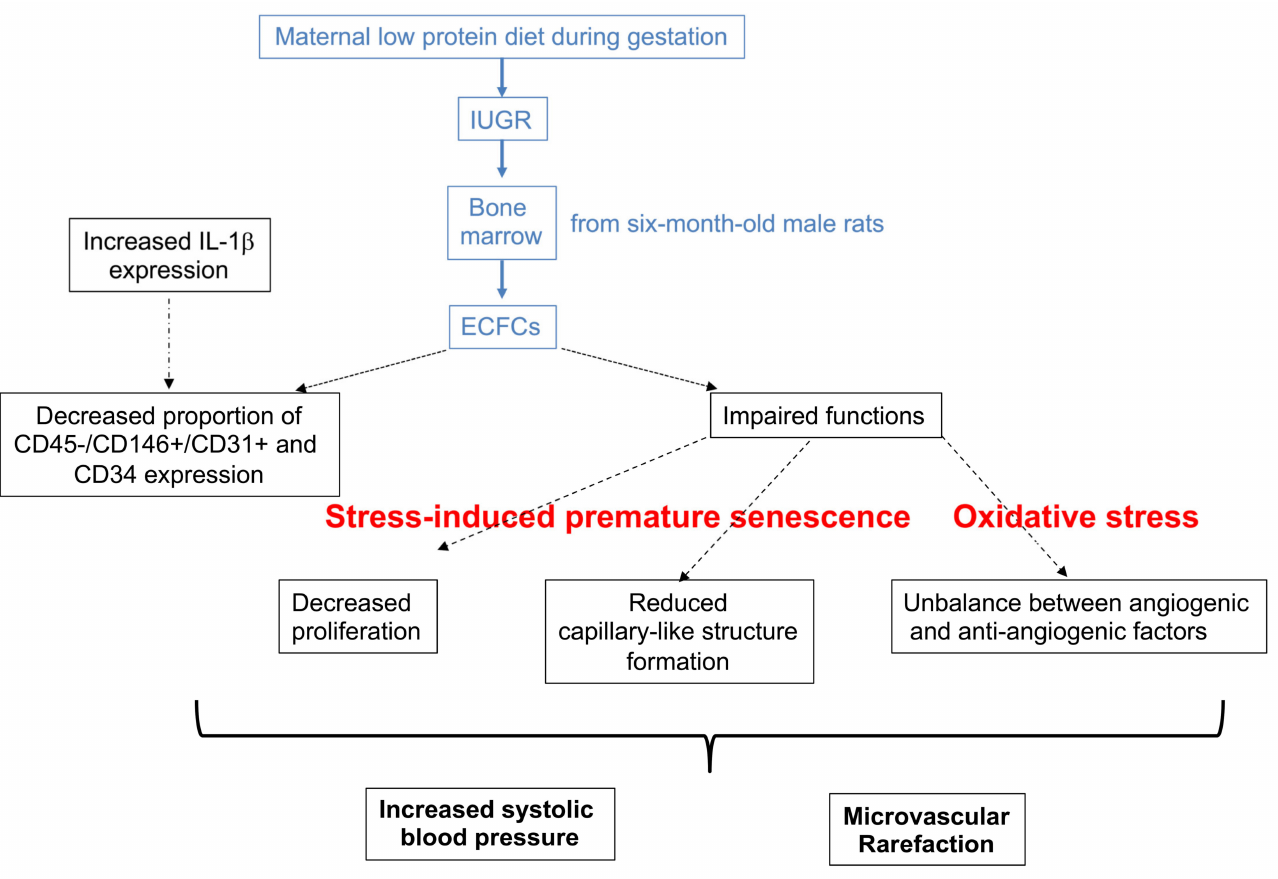
Figure 13. ECFC dysfunction related to IUGR and developmental programming of arterial hypertension at 6 months of